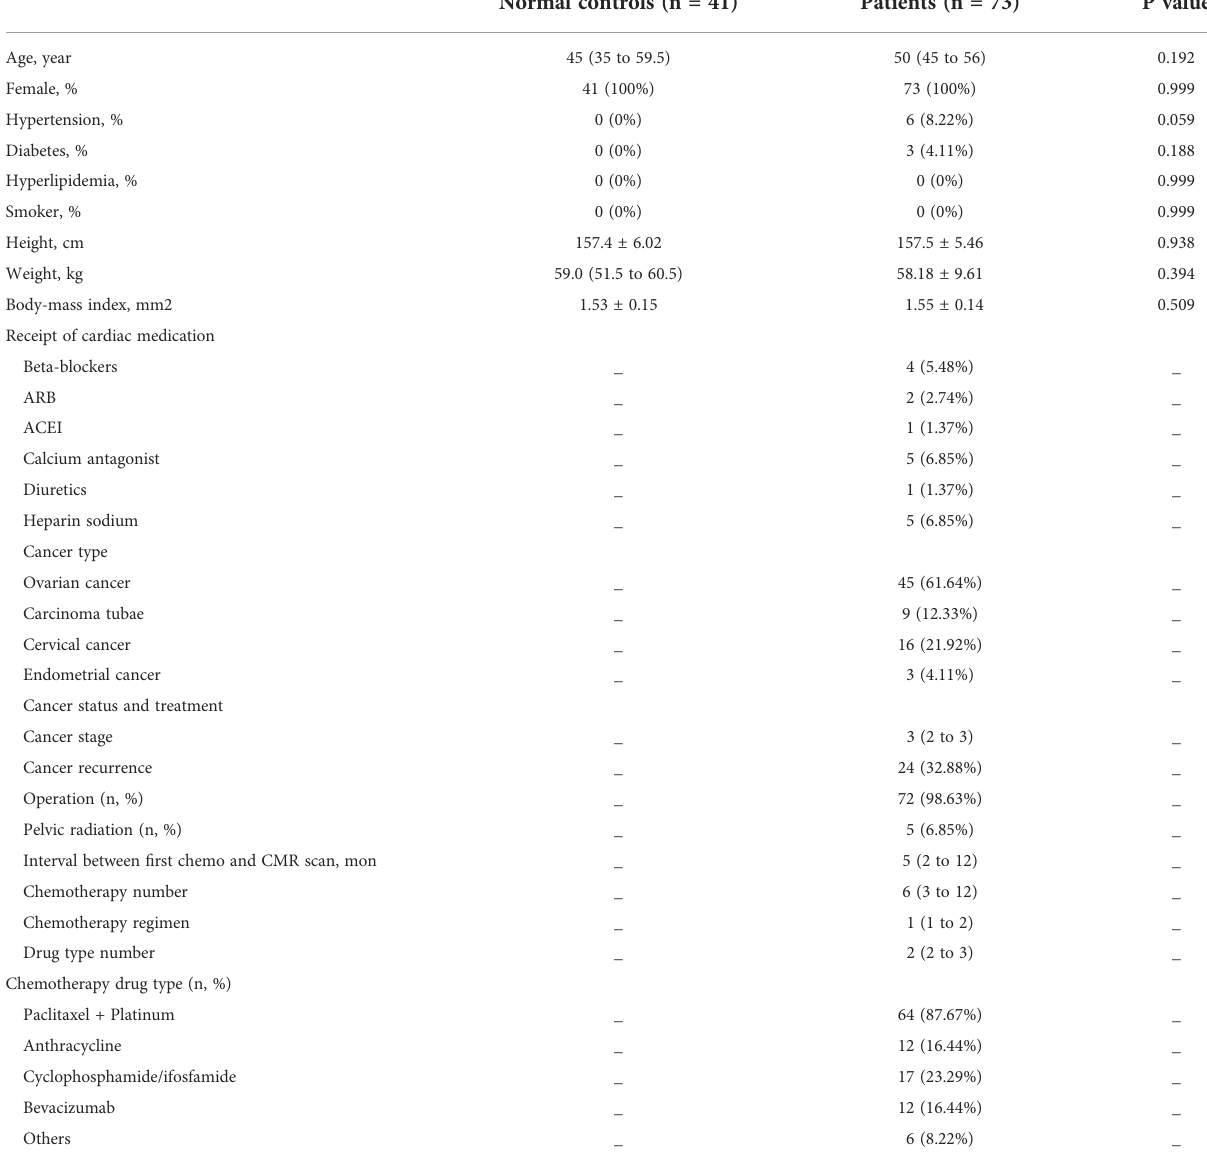
TABLE 1 Baseline characteristics of patients and normal